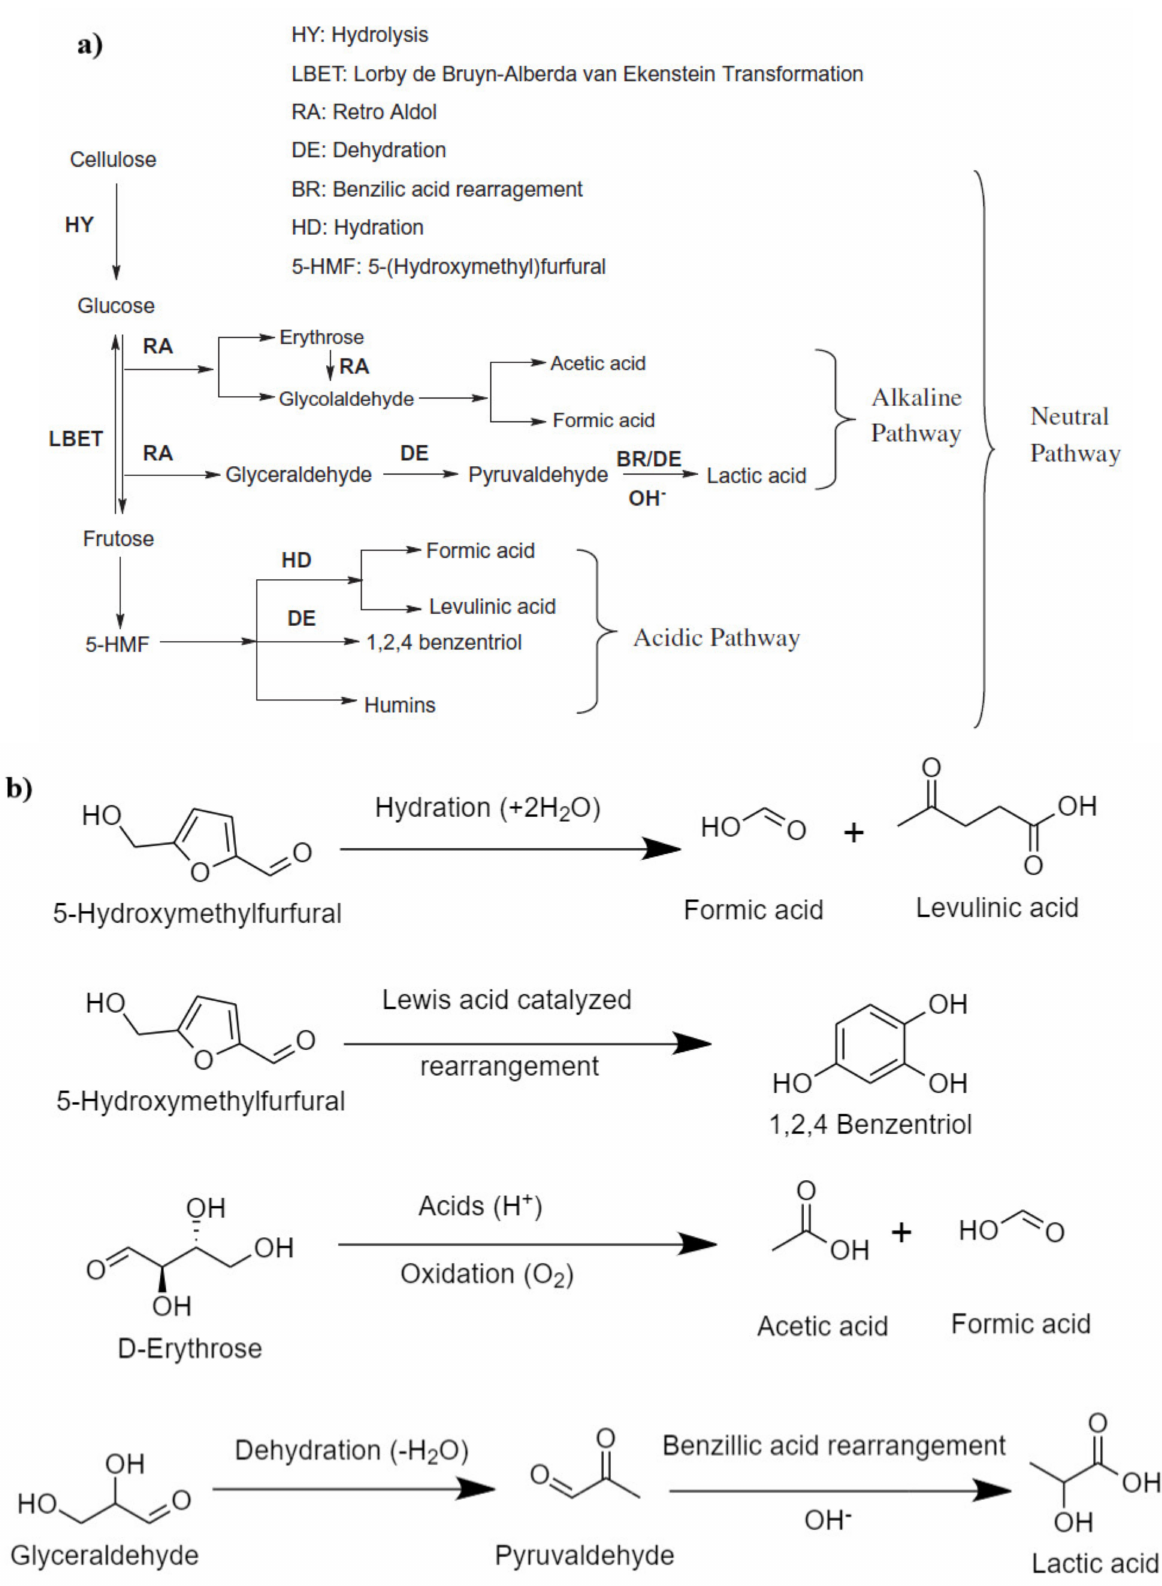
Figure 2. ( a ) Proposed routes of HTL of cellulose (adapted Sudong et al. [45]), copyright from Elsevier 2012, ( b ) major intermediate reactions during HTL of